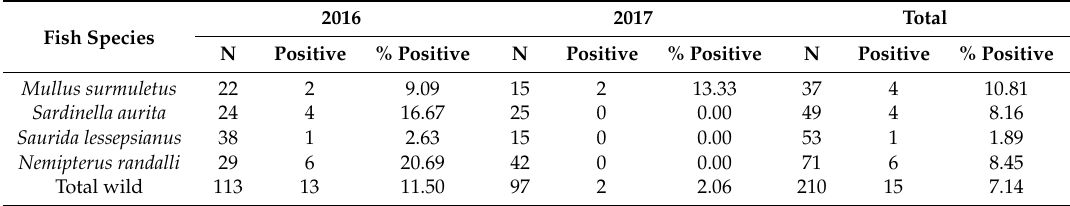
Figure 3. Vibrio sp. phylogenetic tree. Maximum Parsimony analysis phylogenetic tree of the Vibrio sp. derived from 16S rRNA gene partial sequences. The sequence name for positive samples of this study begins with YR and includes the capture year, identification number, tissue (L, liver; K, kidney), host species, and GenBank accession number. The tree was rooted by using S. oneidensis as the outgroup. Numbers on the branches indicate bootstrap proportions (1000 replicates, only values ≥ 70% are reported). Available GenBank and Arb-Silva accession numbers are shown. The scale bar represents one nucleotide substitution per site. Table 5. Vibrio sp. prevalence in wild fish species from the Mediterranean Sea. The results are based on the PCR targeting 16S rRNA segments. Positive results refer to one or more isolated